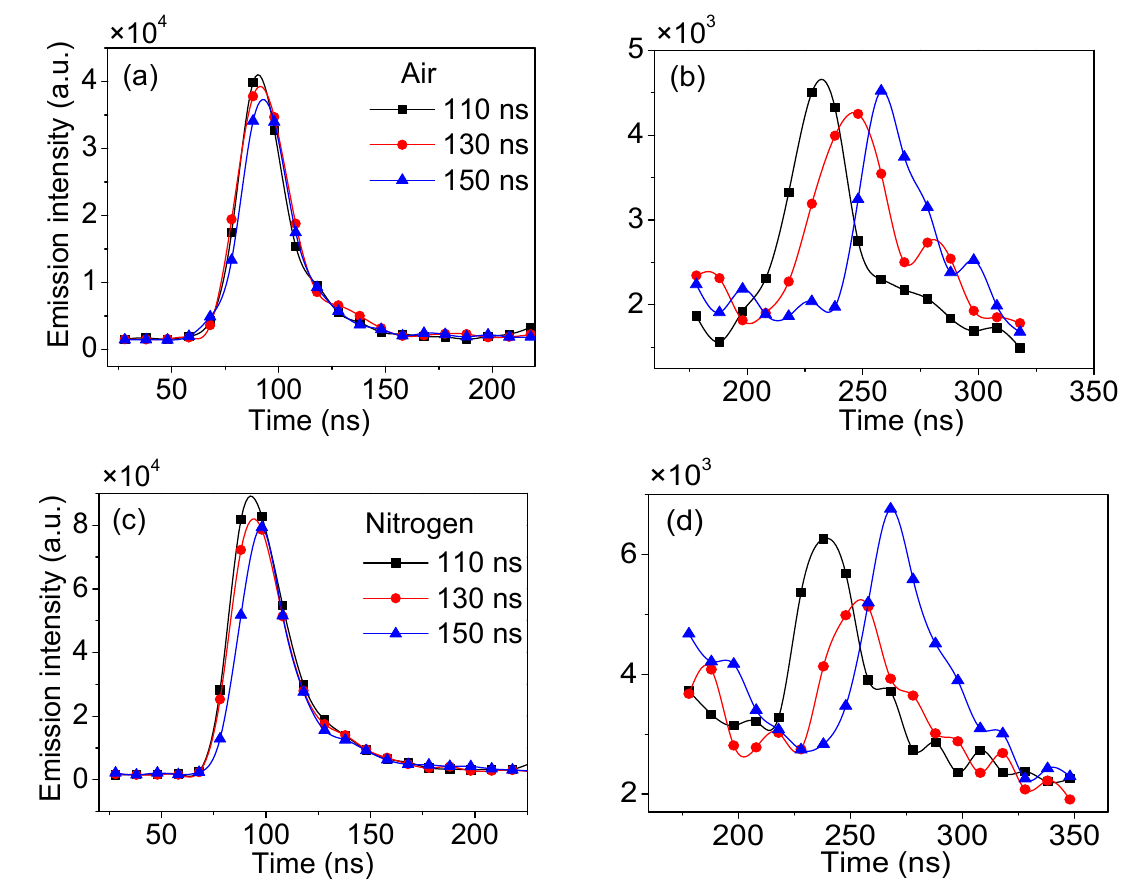
Figure 11. Effects of pulse duration on emission intensity of SPS of N 2 collected from the top and bottom of the reactor under air and nitrogen.